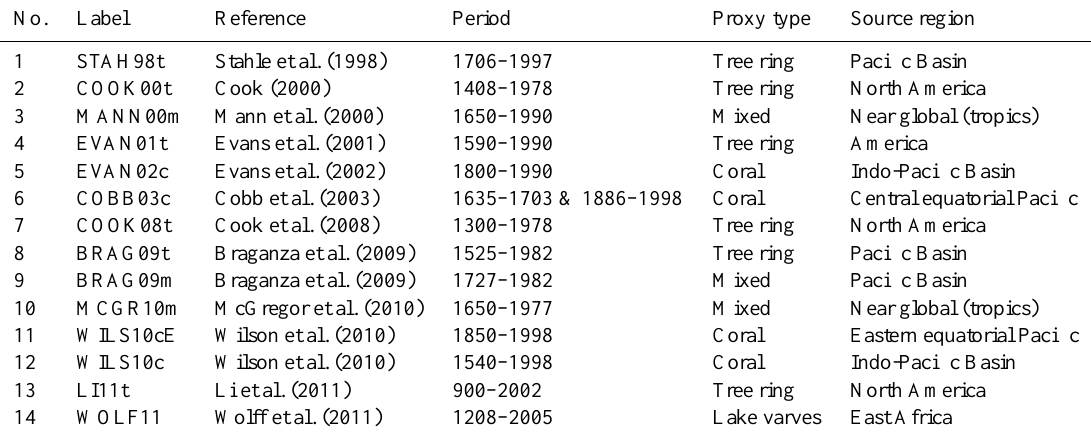
Table 1. Existing ENSO reconstructions employed in this study. Note that these ENSO reconstructions have at least annual resolution and are pre-screened such that they have a correlation of at least 0.5 with the annual mean (July–June) observations of ENSO, represented by Niño 3.4 area-averaged (5 ◦ S–5 ◦ N, 120 ◦ W–170 ◦ W) SST anomalies (SSTA; Table 2). This correlation cutoff ensures the ENSO reconstruction provides a skillful estimate of ENSO variability, at least over the instrumental